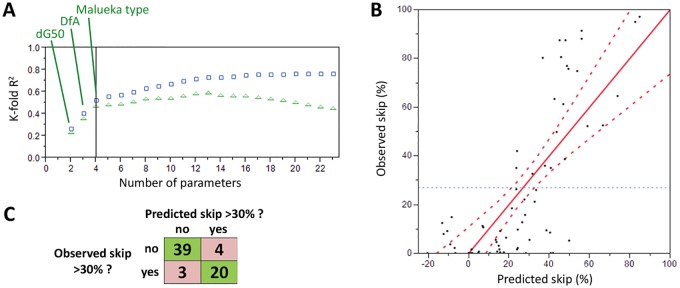
Predictive modelling for PMO oligonucleotides.(A) Descriptive parameters are added consecutively to the model based on their predictive power (except parameter 1, which is the intercept). K-fold R2 (green triangles), an indicator of the likelihood of the model to be predictive of new datasets, increases markedly with the addition of dG50 (binding energy of the oligo to a region encompassing the target site and 50 base flanks), DfA, the distance of the target from the upstream splice acceptor site, and Malueka type, the category of the exon based on splice-related descriptors defined by [38]. R2 (blue squares) is improved by the addition of further parameters but K-fold R2 is only slightly increased. (B) Percentage skipping as reported (Observed skip) against the percentage skipping, as predicted by a standard least squares model for the skipping efficacy of PMO oligos, based on the parameters: dG50, DfA, Malueka type, and the factorial of dG50 x DfA. A line of best fit is marked (red line) with 0.05 significance curves (dashed red lines), and average of observed (dashed blue line). (C) Confusion matrix showing the numbers of correct and incorrect predictions of skipping efficacy greater or less than 30% by an ordinal logistic model constructed using the same parameters (green background = correctly predicted; red = incorrectly predicted).